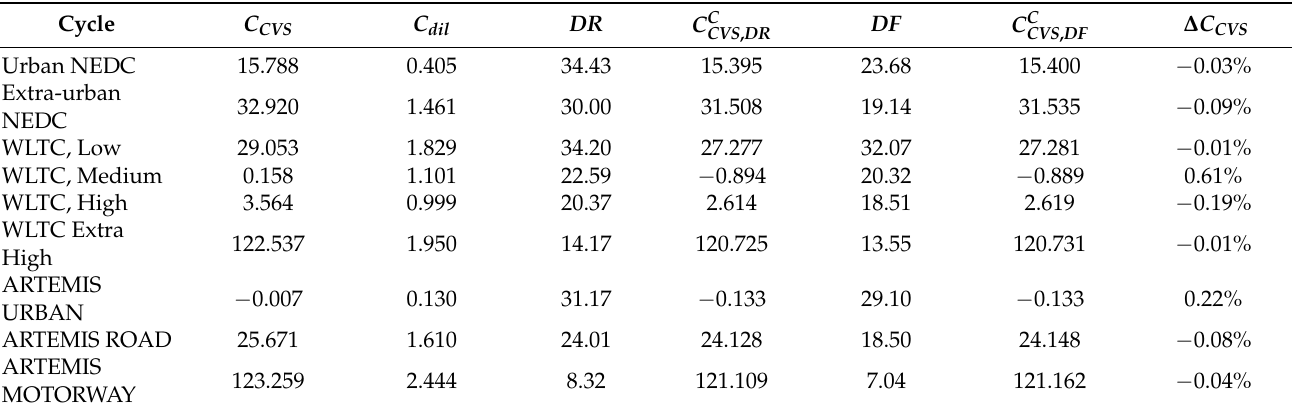
Table A12. The C CVS,corr calculated based on Equations (5) and (21) for Euro 6 WLTP vehicle with SI engine, CO concentration